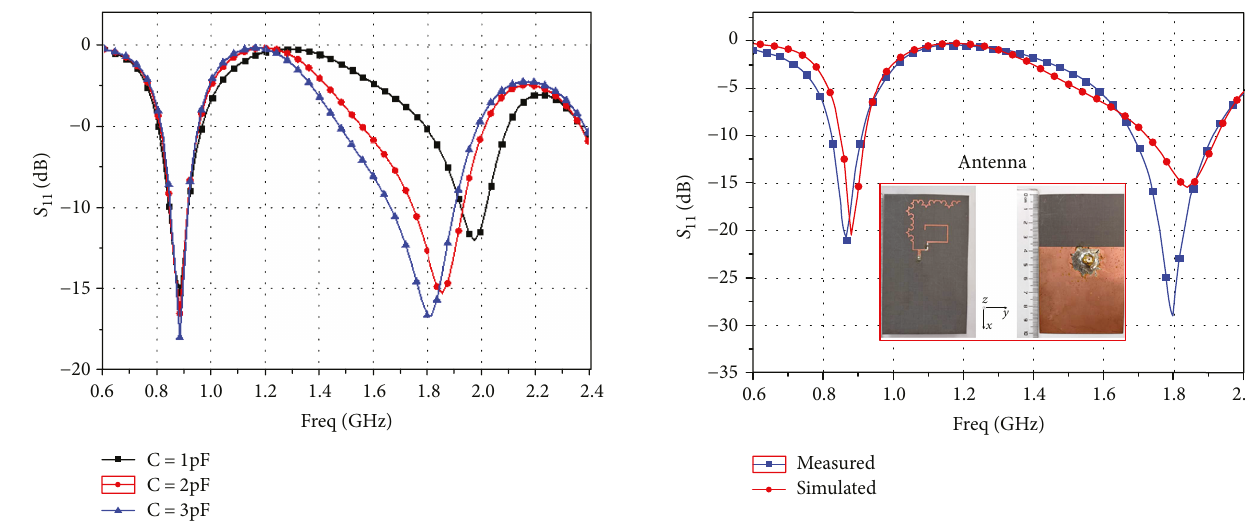
11 of the proposed dual-band